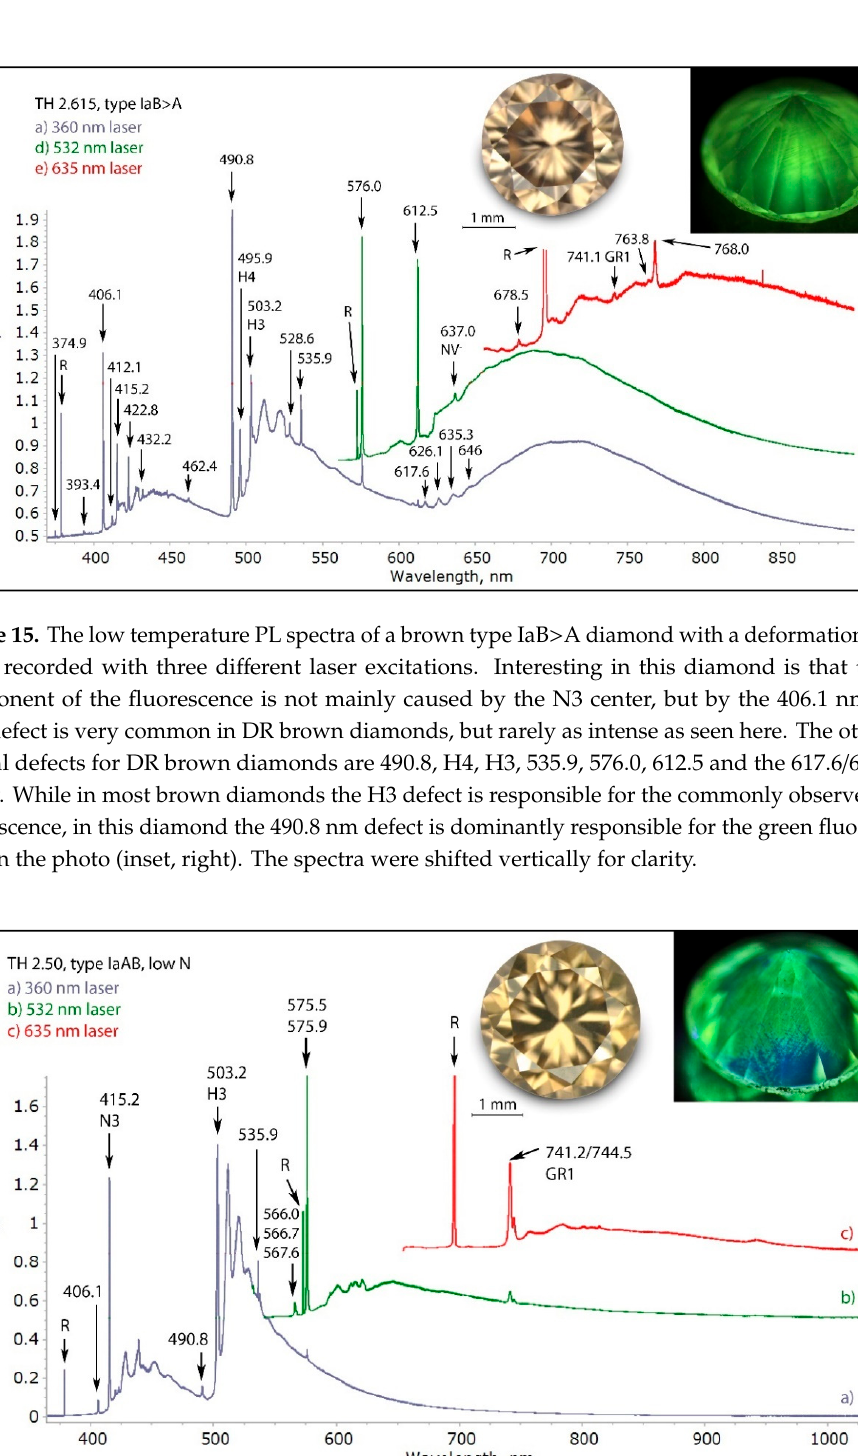
Figure 16. The low temperature PL spectra of a brown-yellow low nitrogen type IaAB diamond with a deformation-related color, recorded with three different laser excitations. While many of the defects observed are the same as the ones observed in higher nitrogen containing brown diamonds, some defects are notably absent with the most noteworthy being the 617.6/626.1 nm center. In this diamond, the H3 and N3 defects are responsible for the green and blue fluorescence seen in the photo (inset, right). This type of spectrum is similar to what can be seen for many type IIa diamonds. The spectra were shifted vertically for clarity.